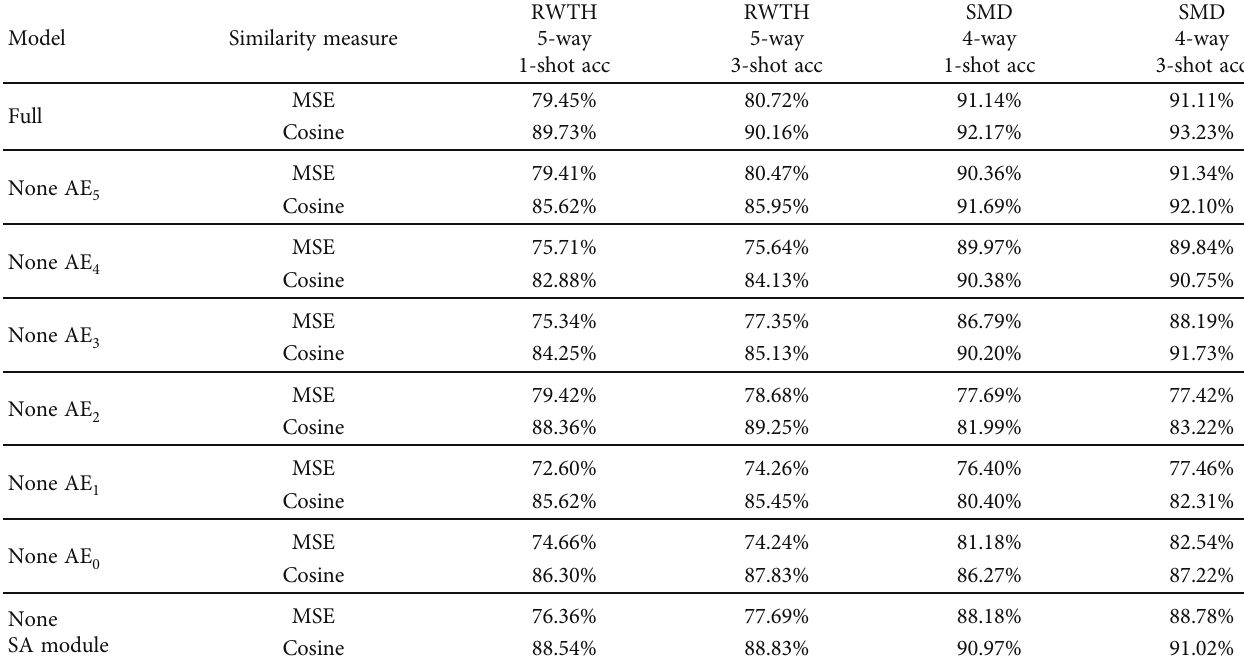
Table 5: Ablation study of the gesture feature extractor